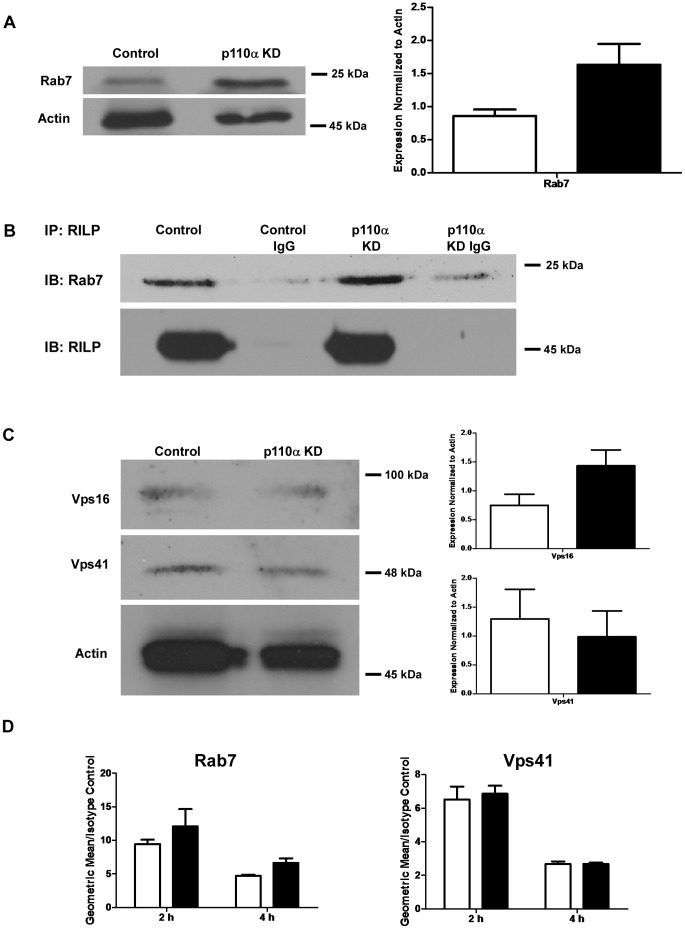
Phagosomes from p110α deficient cells recruit Rab7 and its effectors, RILP and HOPS.
A)
Phagosomes from p110α knockdown cells are not defective in the recruitment of Rab7. Western blots of bead phagosome lysates (4 hours) isolated from control and p110α knockdown cells show no significant differences in recruitment of Rab7. Actin is shown as a loading control. Empty bars  =  control cells, solid bars  =  p110α knockdown cells. Data are means +/− s.e.m., from four independent experiments. B)
Phagosomes from p110α knockdown cells show similar levels of Rab7- RILP interaction as control cells, confirming that the Rab7 present is active. 4 h bead phagosome lysates were immunoprecipitated with an antibody against RILP, then probed for Rab7 and RILP. Isotype IgG was added as a control for non-specific binding. Results are representative of three independent experiments. C)
Phagosomes isolated from p110α deficient cells are not defective in the recruitment of HOPS proteins. Western blots of bead phagosome lysates (4 hours) were probed for the HOPS components Vps41 and Vps16. Densitometry is of means +/− s.e.m., from four independent experiments. D)
Flow organellometry staining of isolated phagosomes (2 h and 4 h) shows kinetics of Rab7 and Vps41 acquisition. Phagosomes were stained for Rab7 and Vps41 and analyzed by flow cytometry. The graph shows geometric means +/− s.e.m. derived from three independent experiments. Open bars  =  Phagosomes isolated from control cells, Solid bars  =  Phagosomes from p110α knockdown cells. No significant differences in Rab7 and Vps41 recruitment were seen between phagosomes isolated from control and p110α knockdown cells.